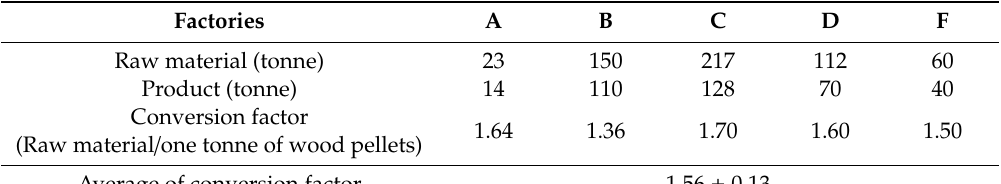
Table 1. Conversion factor from five wood pellet factories.